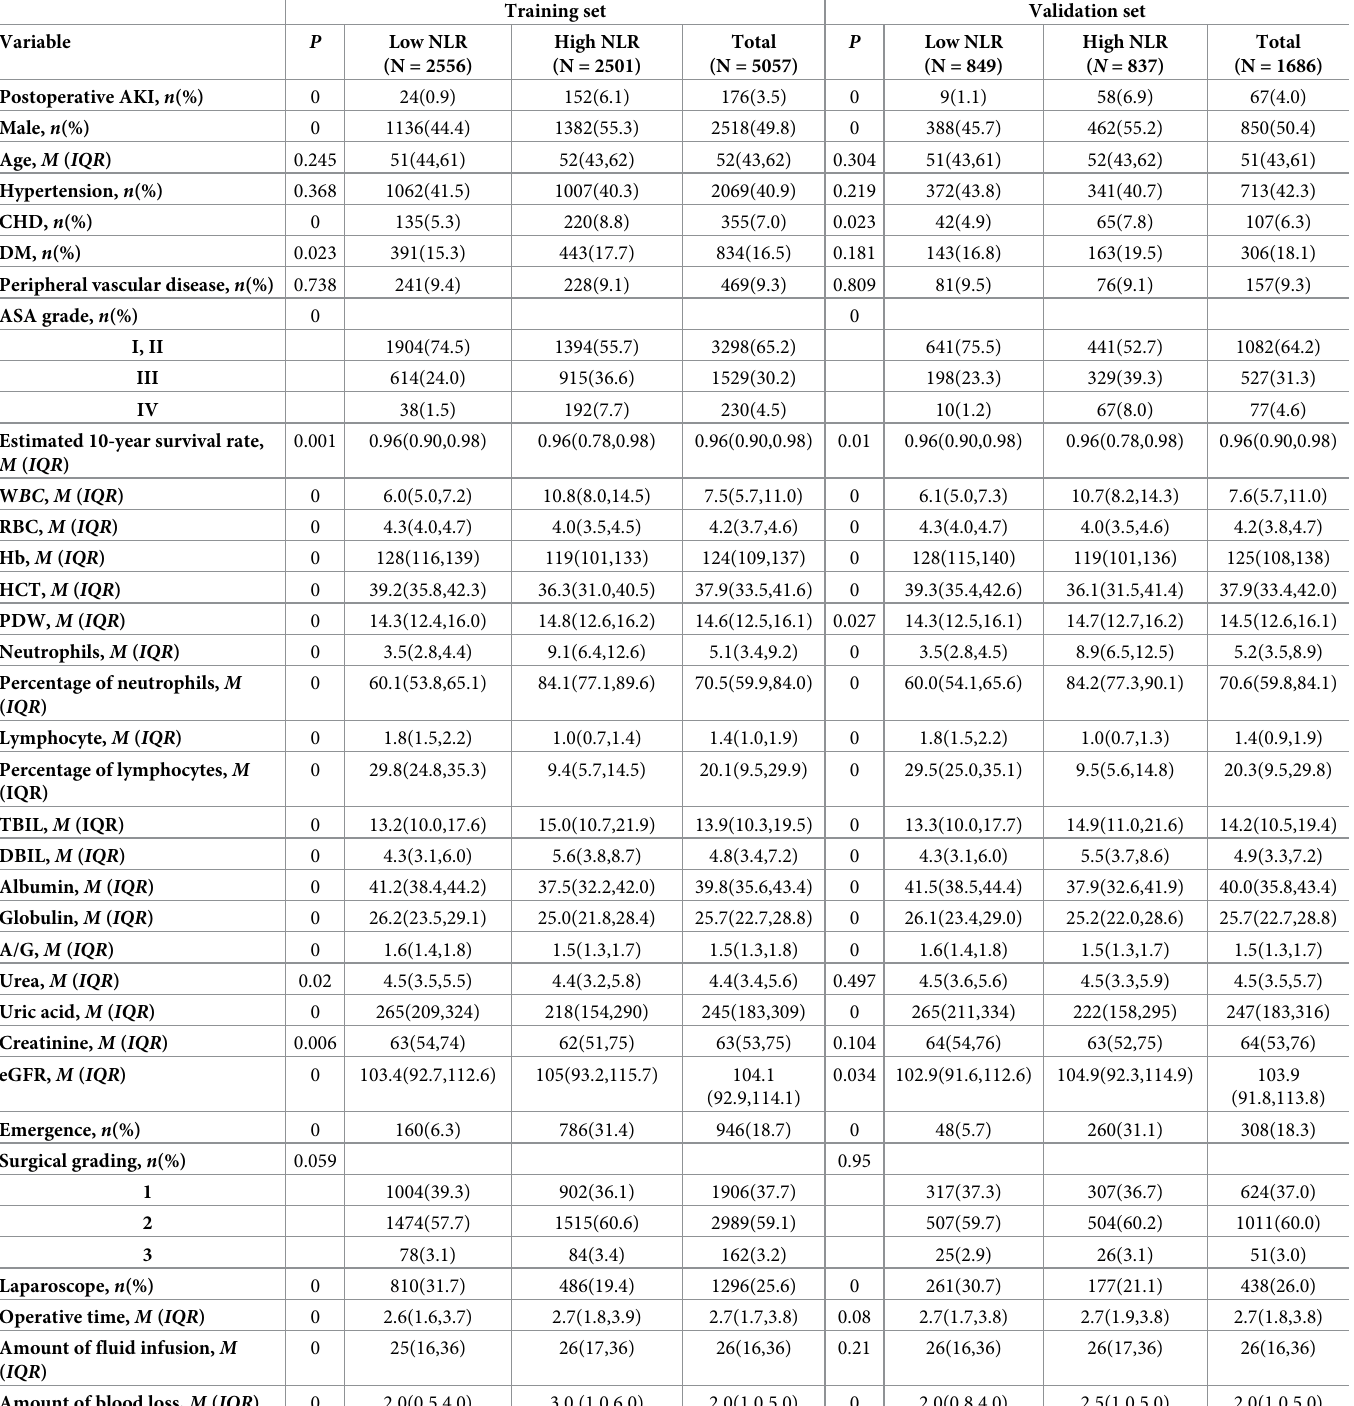
Table 1. Variables in training set and validation